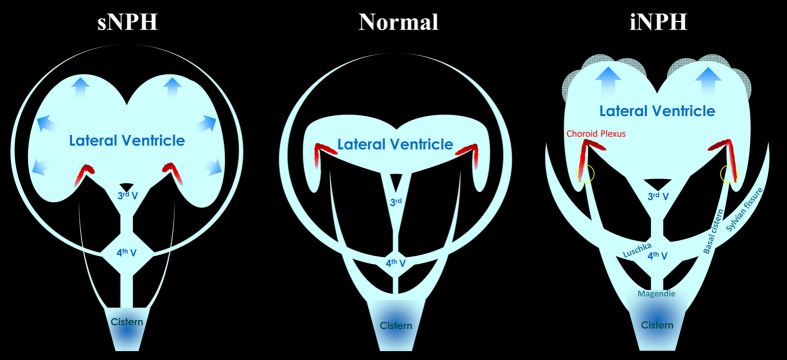
Schematic diagram showing the distribution of CSF in patients with iNPH and sNPH, compared to normal brains.In iNPH patients, the inferior horn of the lateral ventricles is directly connected with the basal cistern at the inferior choroidal point of the choroidal fissure (yellow circle) inside the choroid plexus.